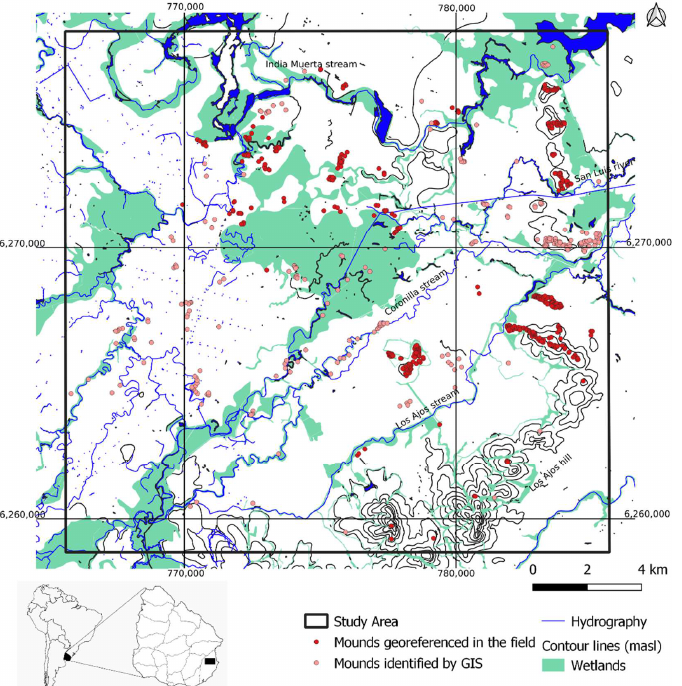
Figure 5. Map of the location of mounds in the macro-region of India Muerta via remote sensing and archaeological prospection in the field. Coordinates WSG84/UTM zone 21S and UTM zone 22S. Masl abbreviation corresponds to meters above sea level.